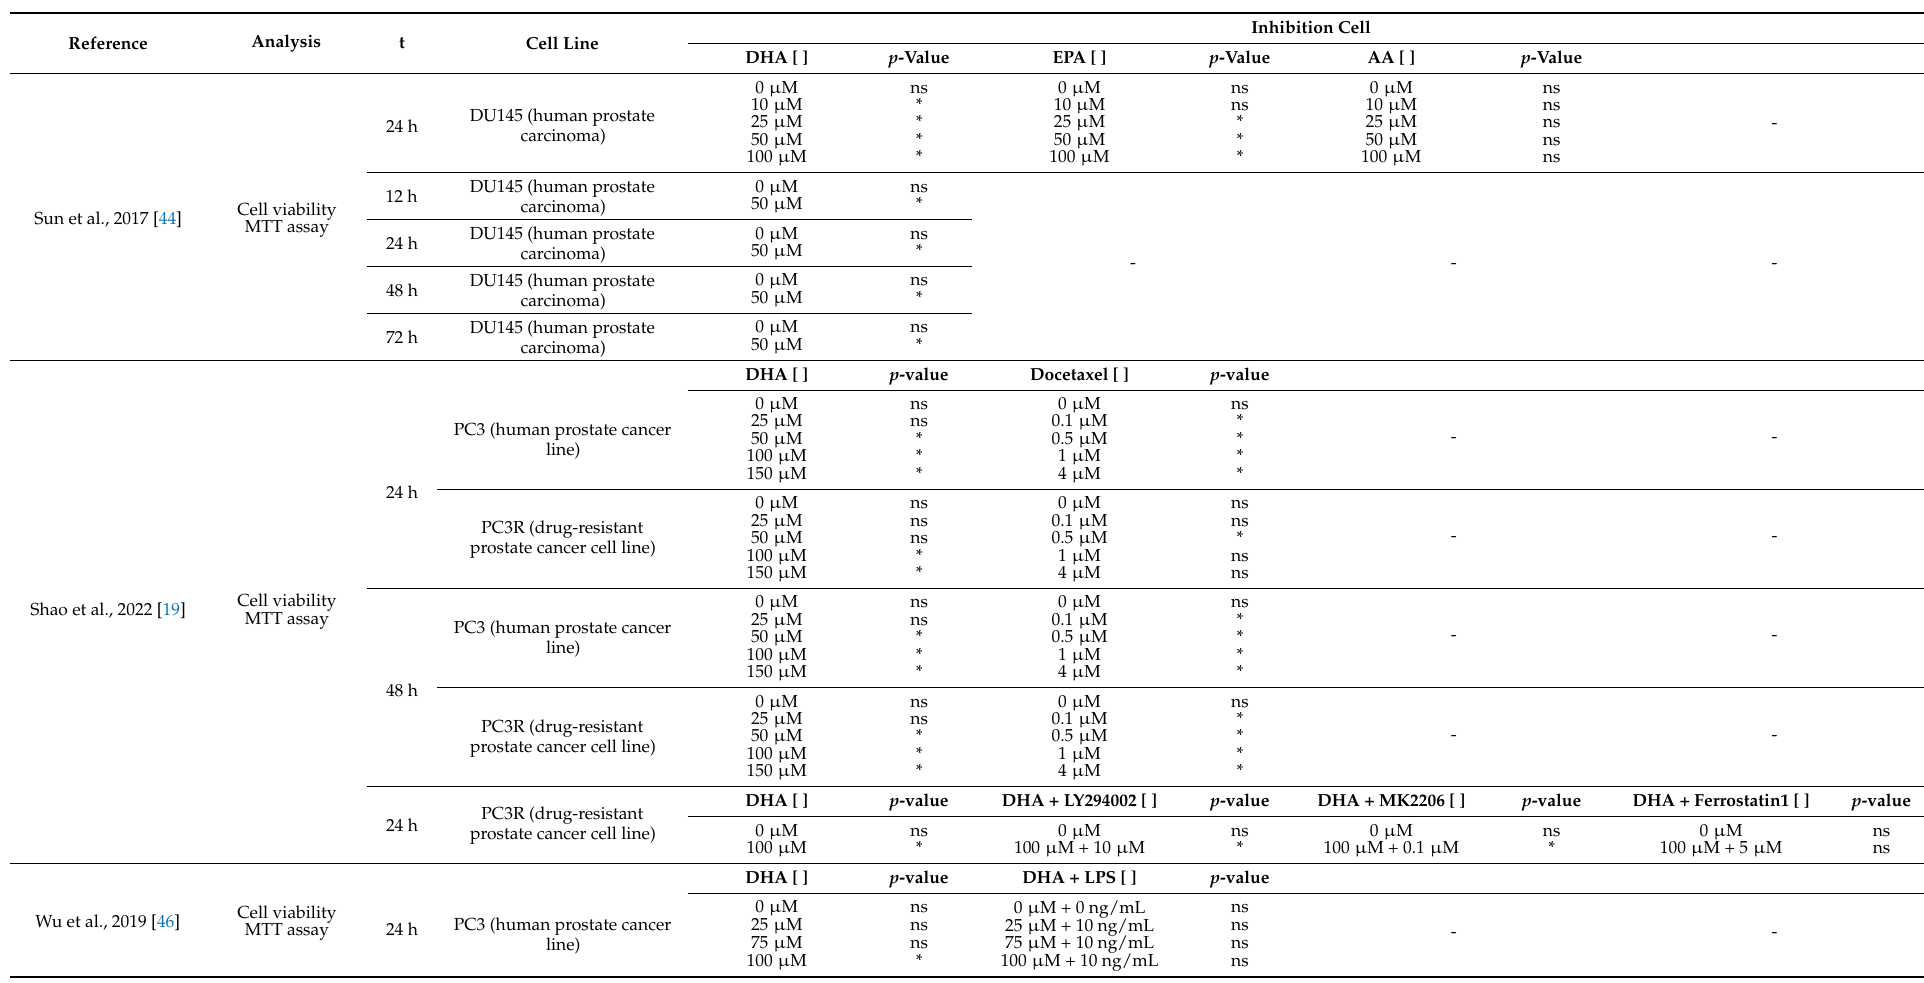
Table 5. Analysis results of the in vitro cytotoxicity tests on prostate cancer cell lines. DHA: docosahexaenoic acid; EPA: eicosapentaenoic